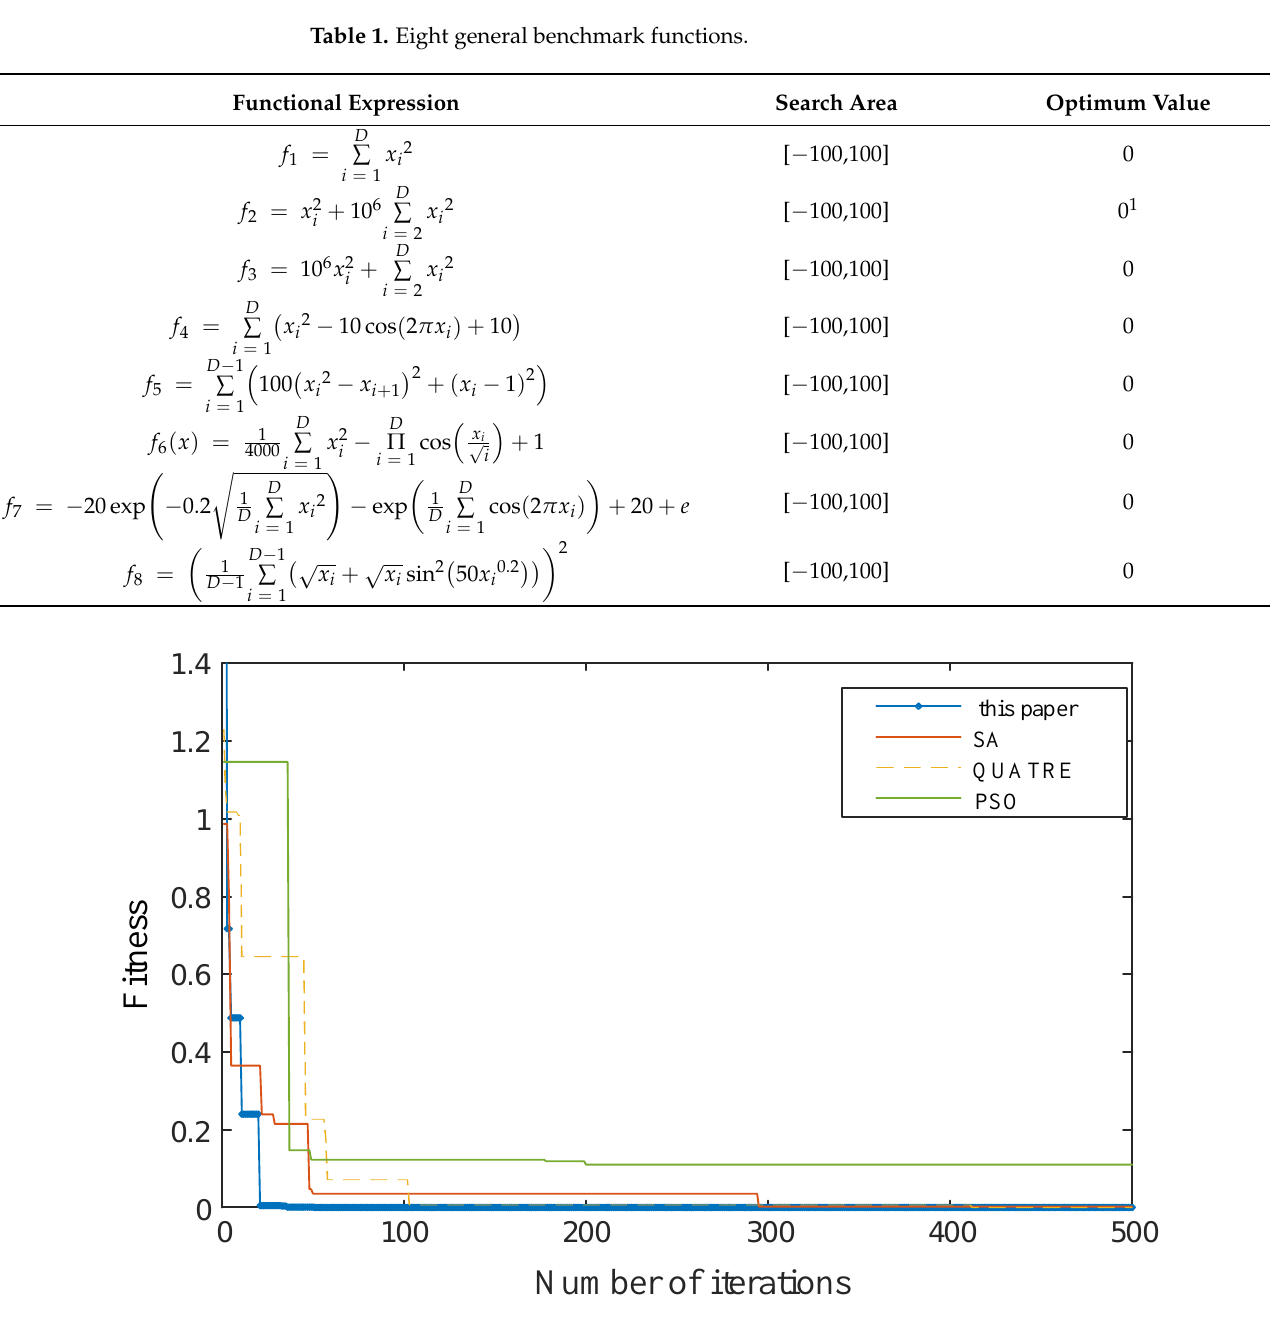
Figure 5. Iterative optimization of f 1 test function.